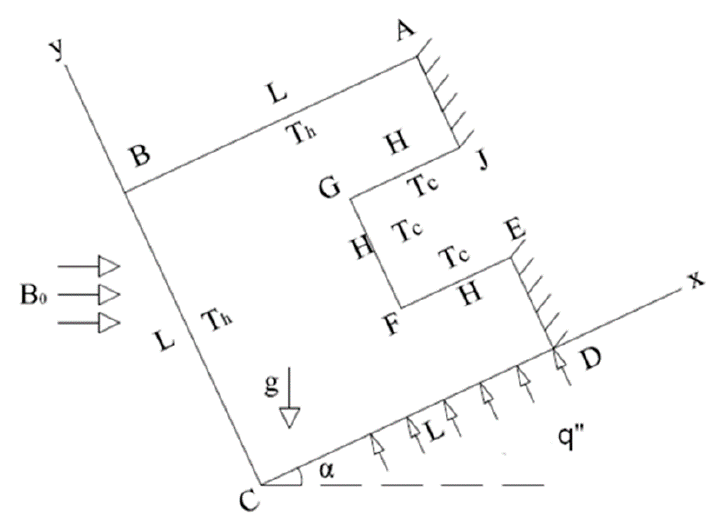
Figure 2. Sketch of the analyzed region.